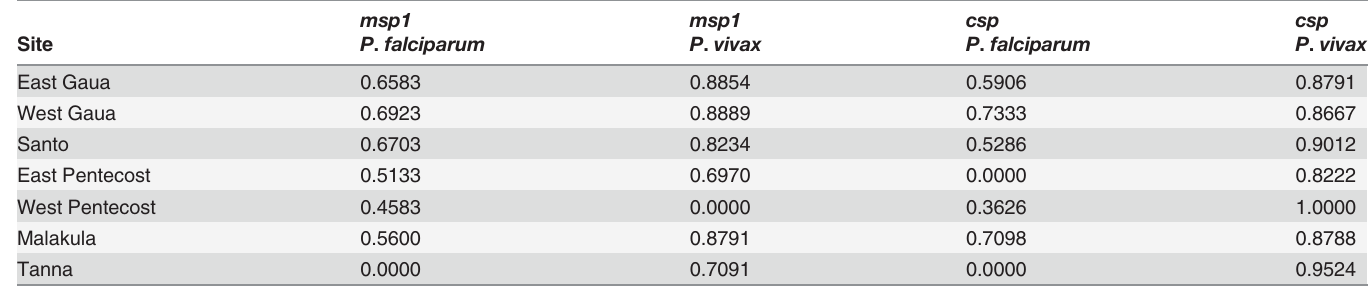
Table 2. Haplotype diversities of msp1 and csp in P . falciparum and P . vivax from seven sites in